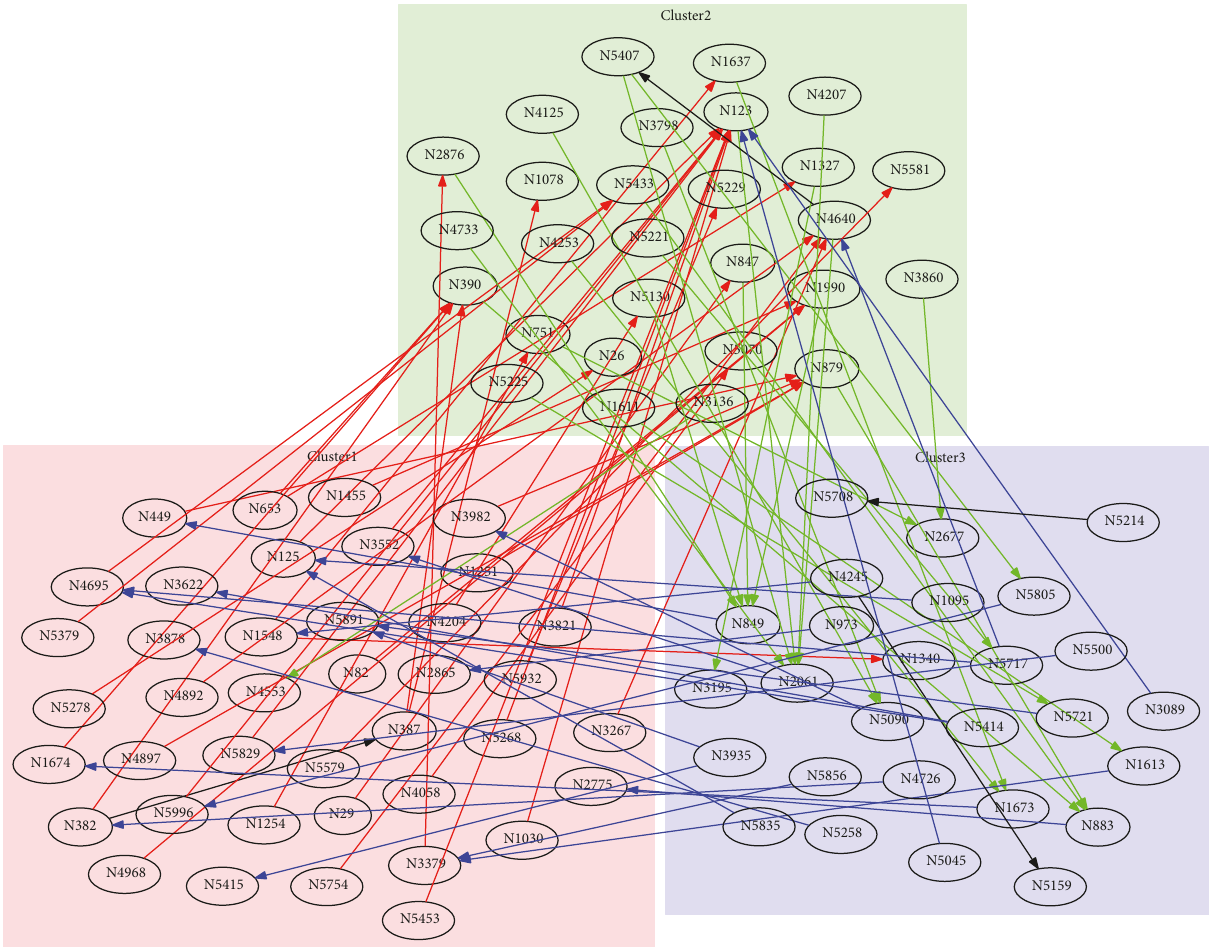
Figure 19: Clustering for Gnutella peer to peer network with 4.6% of initial number of nodes in clusters C1, C2, and C3. Nodes labels are nodes numbers in the network before removing sources. The nodes from cluster C1 are situated on light red background. The nodes from cluster C2 are situated on light green background. The nodes from cluster C3 are situated on light blue background. The edges going from cluster C1 are red, the edges going from cluster C2 are green, the edges going from cluster C3 are blue, and the edges inside clusters are black.